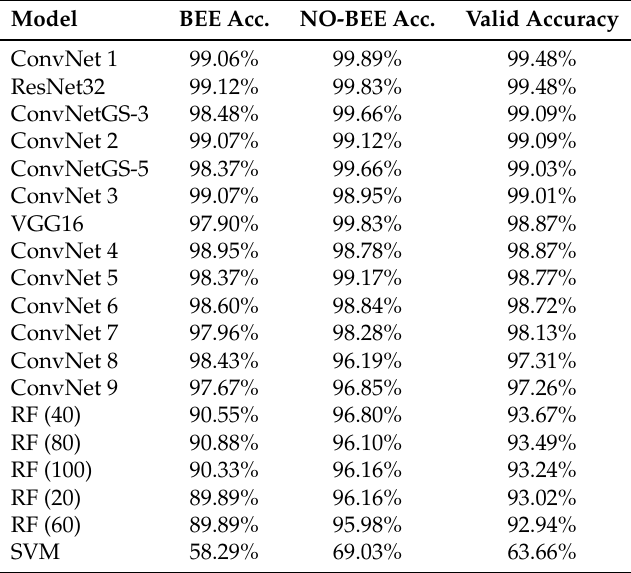
Figure 9. The architecture of the best performing hand-designed ConvNet (ConvNet 1 in Table 3) on BEE1. Table 3. Performance of top hand-designed ConvNet, ResNet32, and VGG16 models (trained for 100 epochs), RFs, and SVMs on BEE1. The number following the RF abbreviation denotes the number of trees. The two top performing auto-designed ConvNets on BEE1 (ConvNetGS-3 and ConvNetGS-5) are included for comparison. The validation accuracies are sorted from highest to